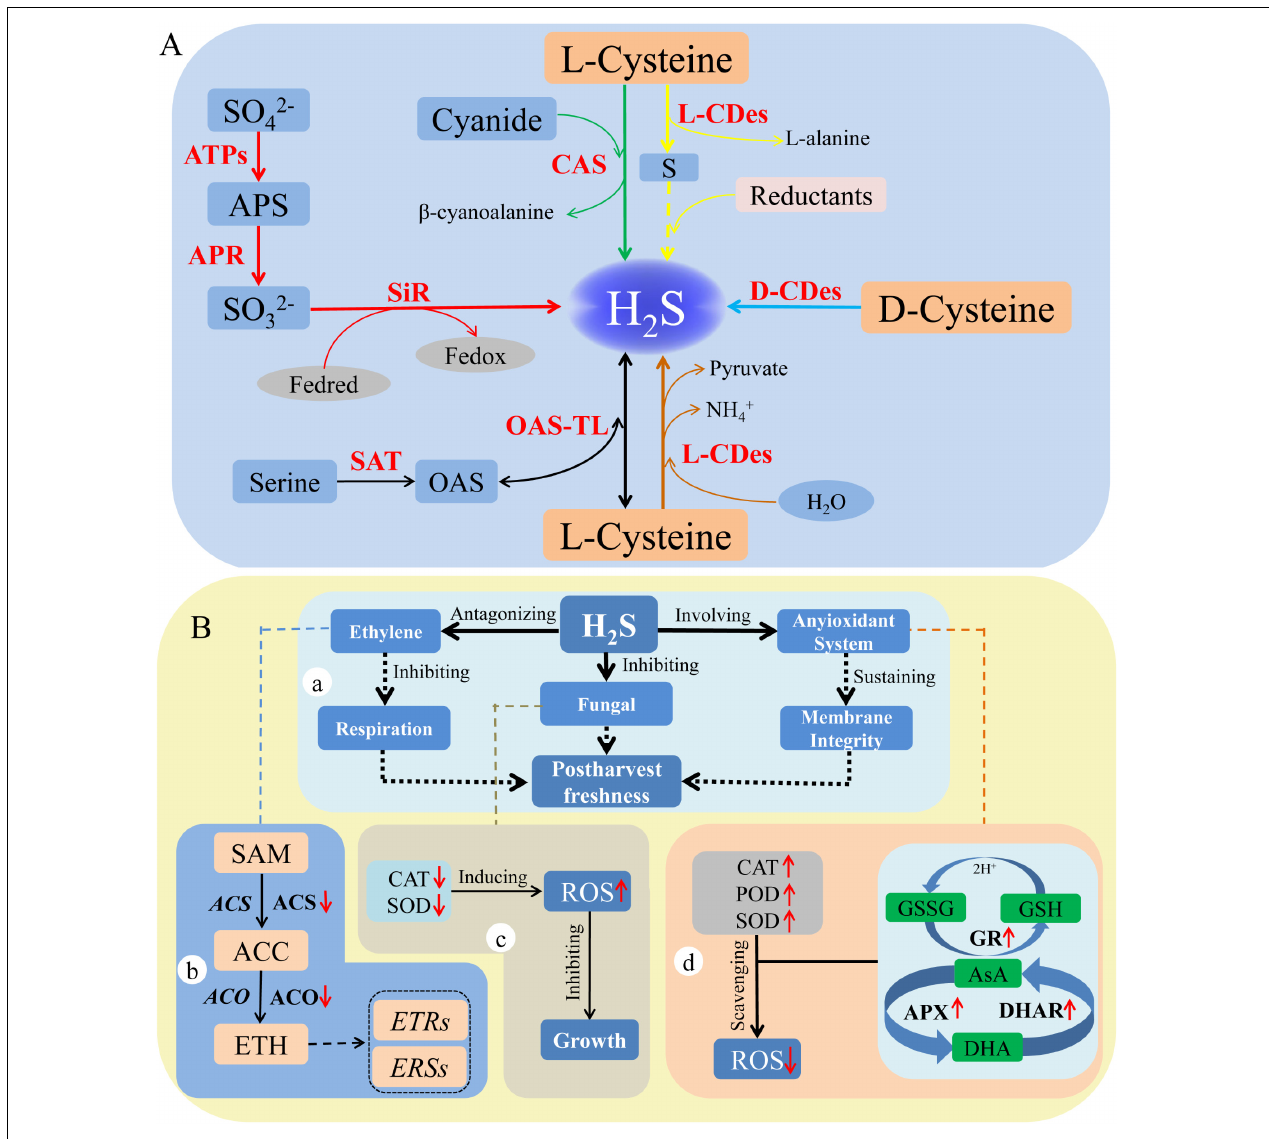
FIGURE 1 | Production and function of hydrogen sulfide in plants. Production (A) : The red arrows indicate sulfite is reduced to H 2 S (Takahashi et al., 2011); the green arrows indicate H 2 S is produced from L -CDes catalytic pathway (Harrington and Smith, 1980); the yellow arrows show H 2 S generation in the presence of reductants (Papenbrock et al., 2007); the light blue arrows represent H 2 S generated from the pathway catalyzed by D -CDes (Riemenschneider et al., 2005); the brown arrows show the H 2 S was generated from the reaction of L -cysteine and cyanide (Hatzfeld et al., 2000); the black arrows show H 2 S is produced from the reverse reaction of synthesis of cysteine (Li, 2015). The red words represent the key enzymes involving in various pathways. Function (B) : a, the roles of H 2 S in delaying senescence and decay of horticultural products. b, the involvement of H 2 S in the generation and signaling of transduction of ethylene. c, the effect of H 2 S on antioxidant enzymes in vivo the fungi. d, the roles of H 2 S in regulating the antioxidant system in horticultural